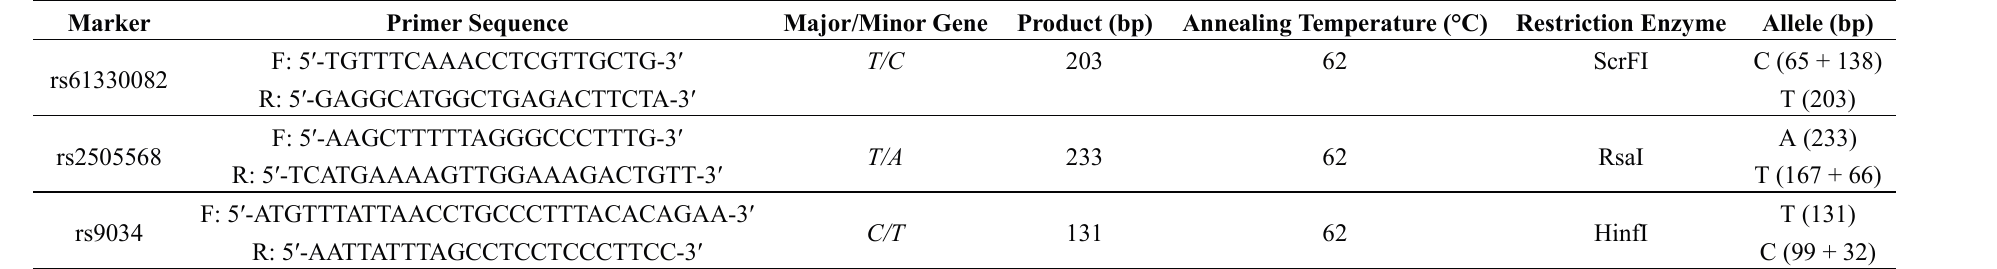
Table 5. Polymorphic SNPs markers, PCR primers, restriction enzymes and corresponding